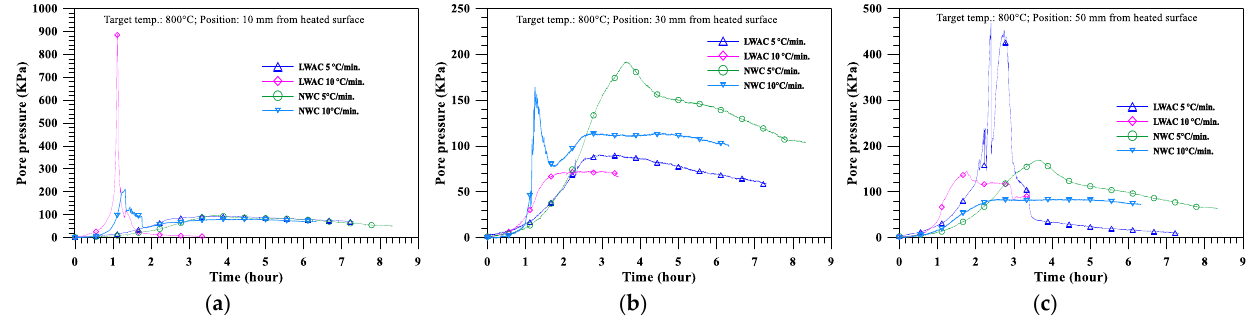
Figure 23. Effect of the heating rate on the pore pressure of the air-dried specimens performed at a target temperature of 800 °C: ( a ) 10; ( b ) 30; ( c ) 50 mm